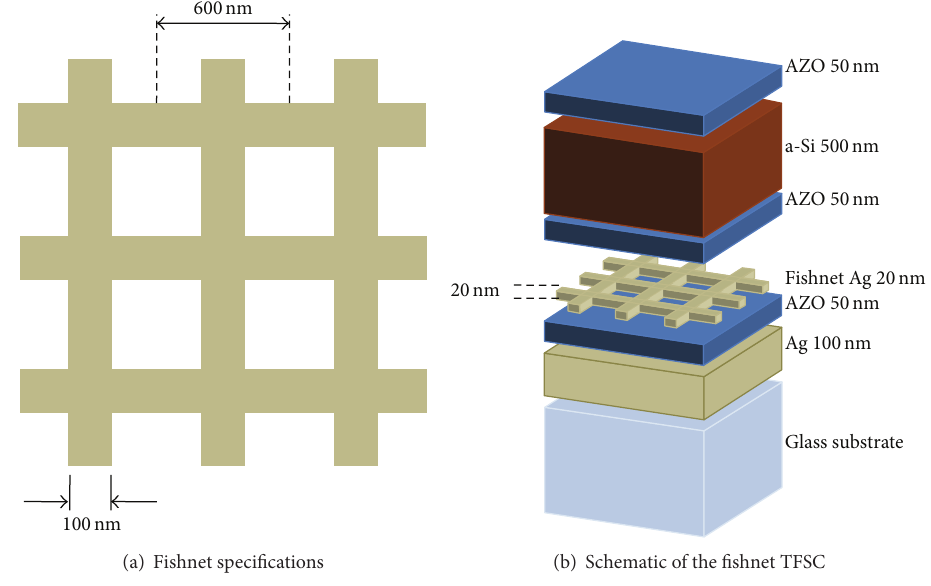
Figure 1: Optimized model for the TFSC with a fishnet in the back spacer